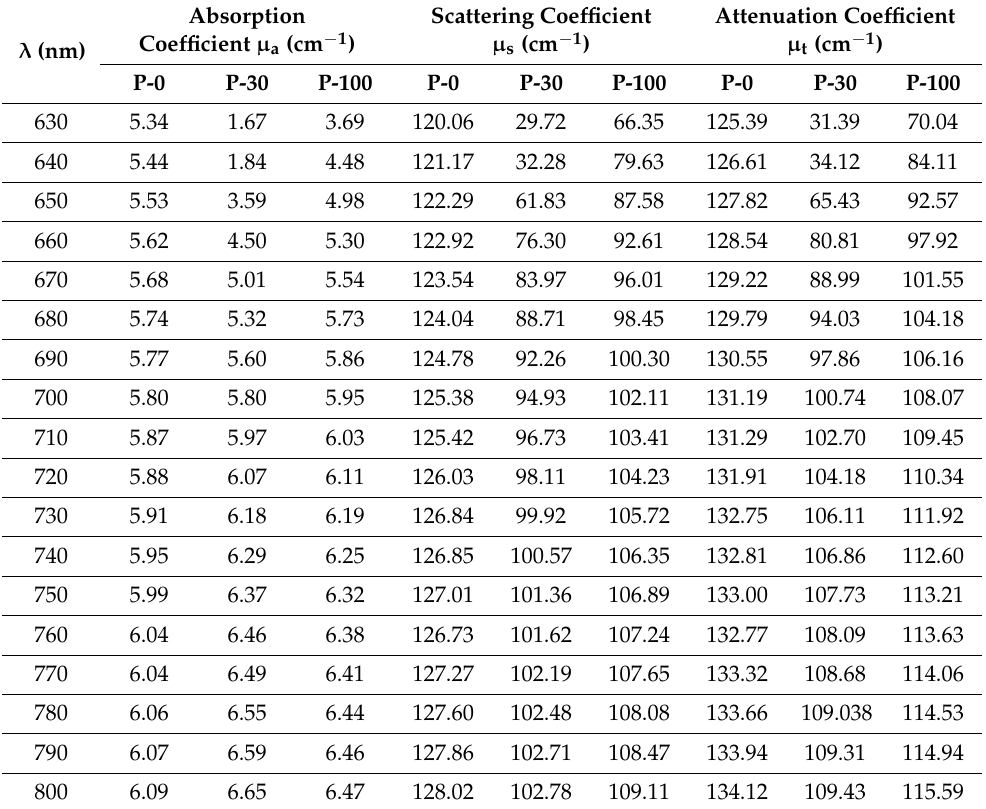
Table 1. Optical properties of UHMWPE samples at particular